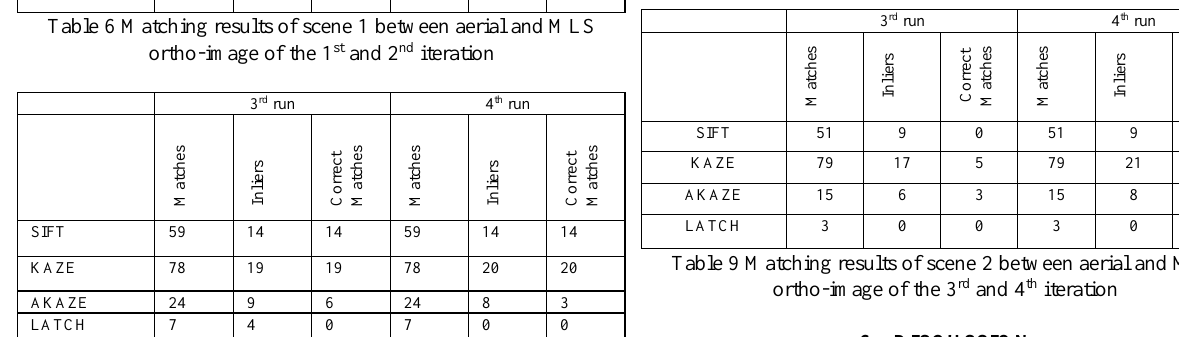
Table 8 Matching results of scene 2 between aerial and MLS ortho-image of the 1 st and 2 nd iteration